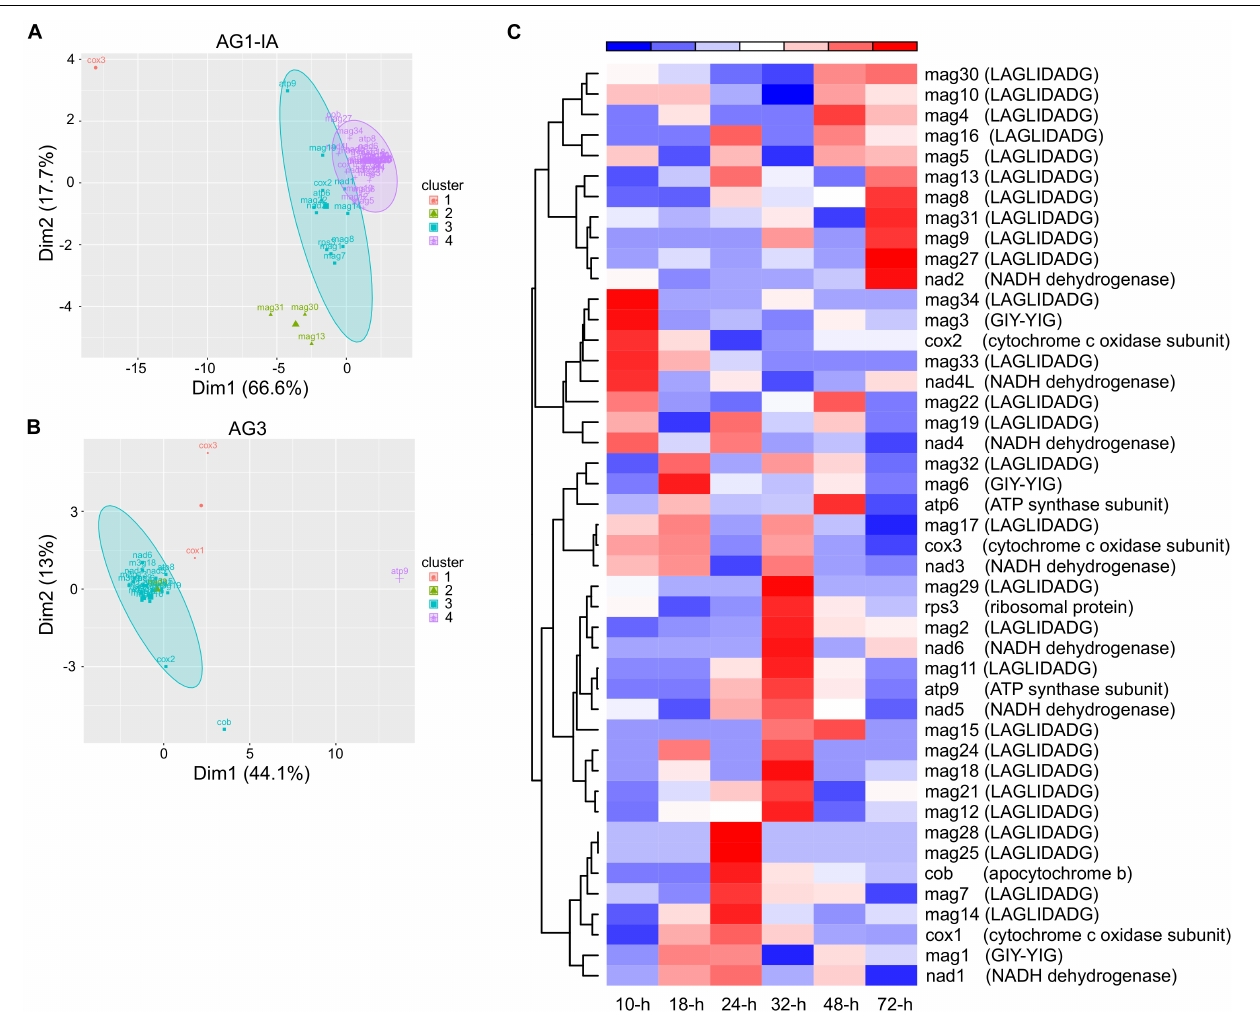
FIGURE 5 | The expression patterns of genes from Rhizoctonia solani mitogenomes. (A,B) The distribution of gene clusters from AG1-IA and AG3. (C) The heatmap of AG1-IA genes after infecting rice at 10, 18, 24, 32, 48, and 72